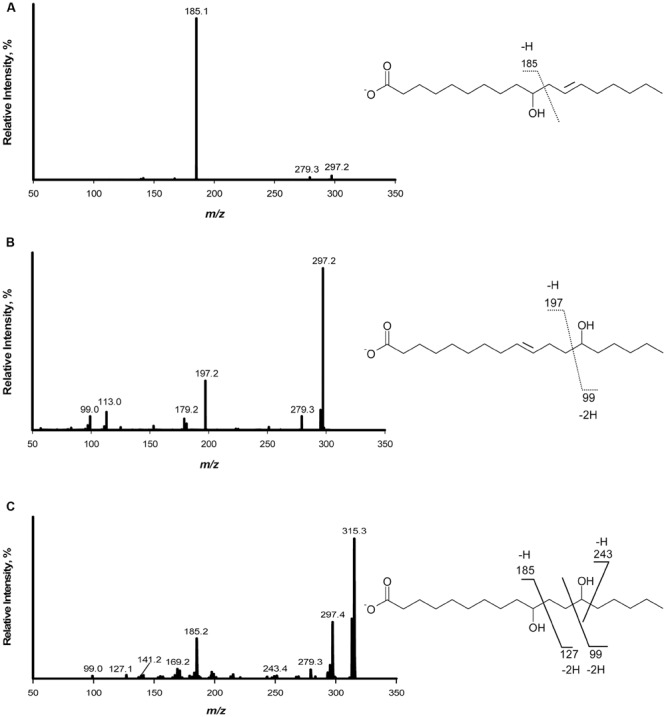
Fragmentation pattern and APPI-MS/MS spectra of hydroxy fatty acids produced when linoleic acid was used as substrate. (A) Mass spectrum of 10-hydroxy-12- octadecenoic acid; (B) Mass spectrum of 13-hydroxy-9-octadecenoic acid; (C) Mass spectrum of 10,13-dihydroxy octadecanoic acid.